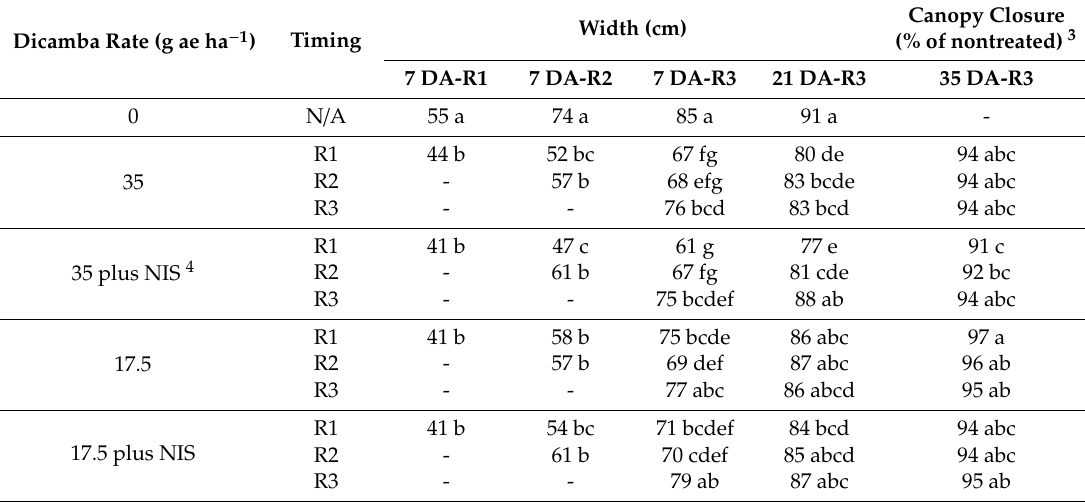
Table 3. Peanut lateral growth and canopy closure following exposure to dicamba 7 DA-R1 1 , 7 DA-R2, and 7 and 21 DA-R3 at Stoneville, MS in 2018 2